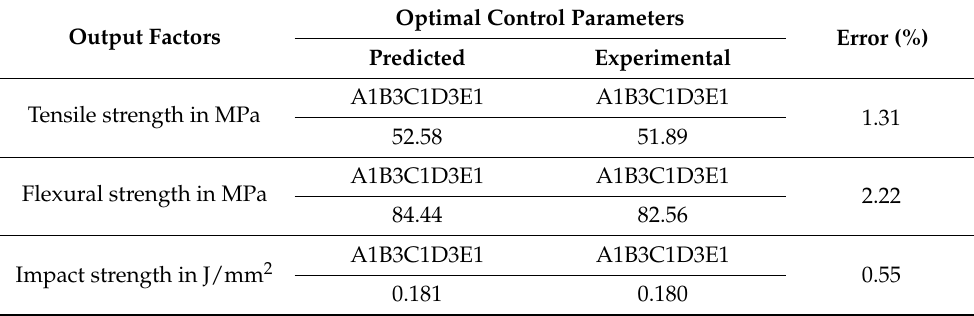
Figure 20. ( a – c ). Predicted results and optimum process parameters. Table 9. Predicted and experimental results with error